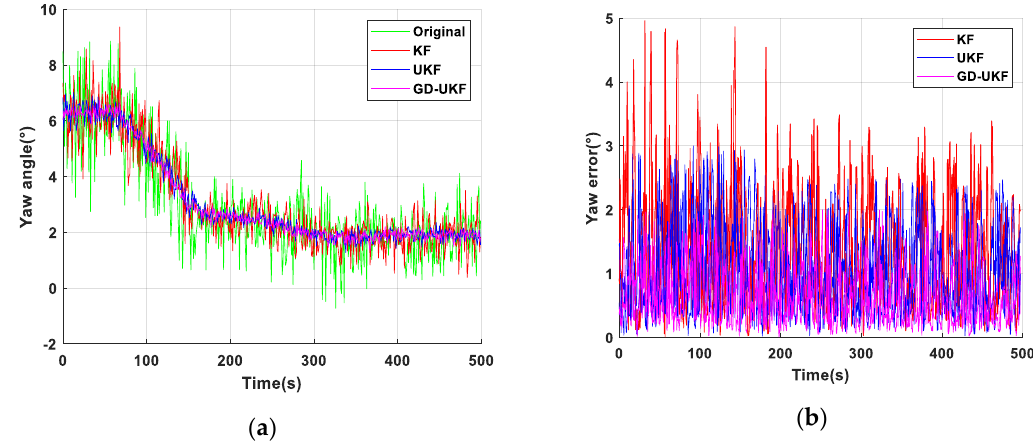
Figure 11. Estimation results of yaw angle tested in industrial experiment: ( a ) yaw angle estimation based on three methods; ( b ) estimation error of three methods.